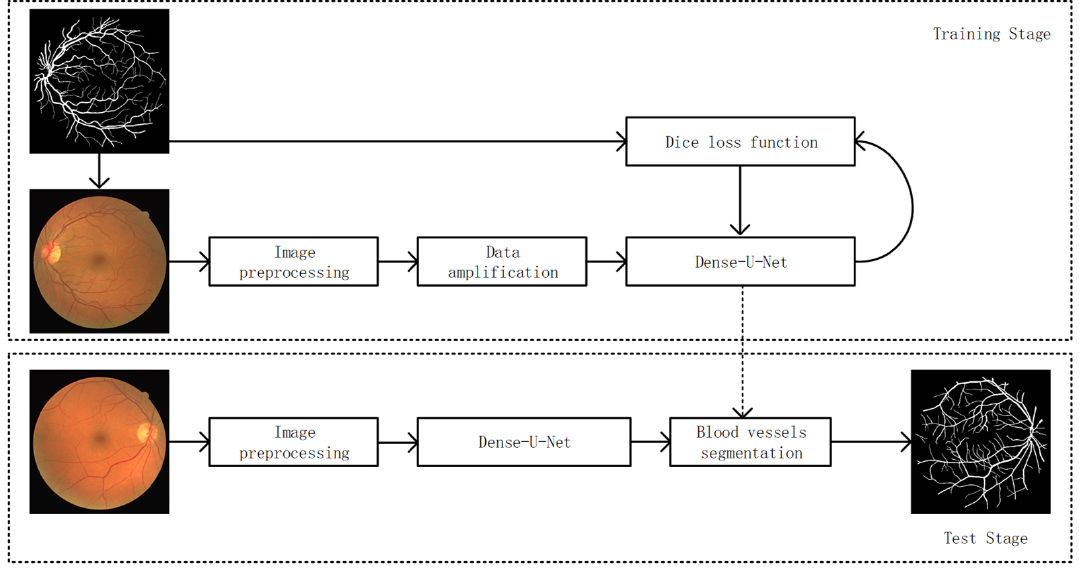
Figure 1. Overall flow chart .